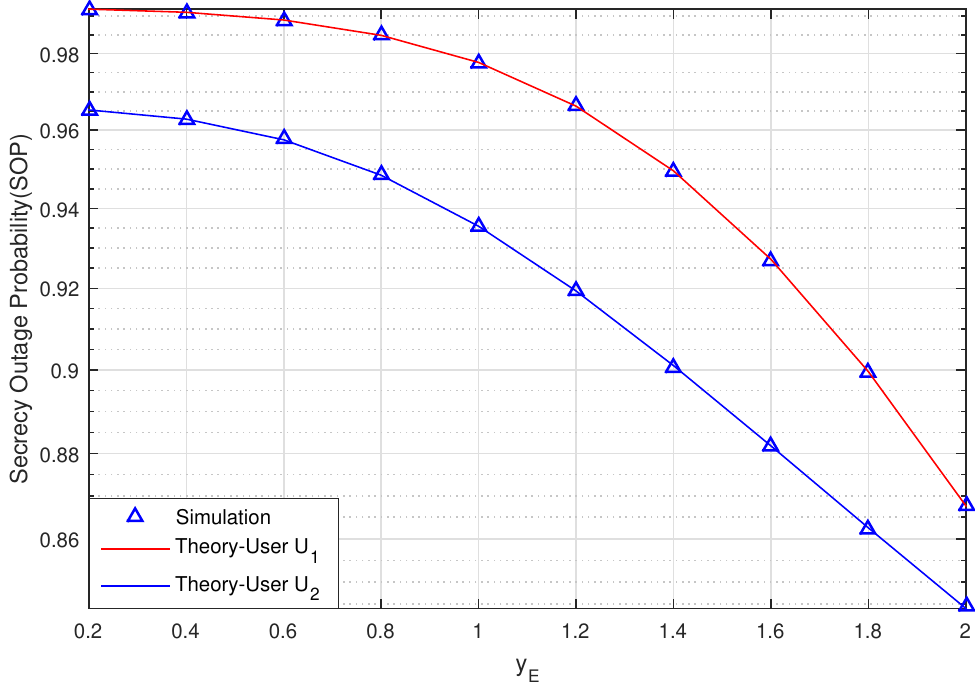
Figure 5. The SOP of U 1 and U 2 versus coordinate y E of eavesdropper E when SNR = 10 (dB).